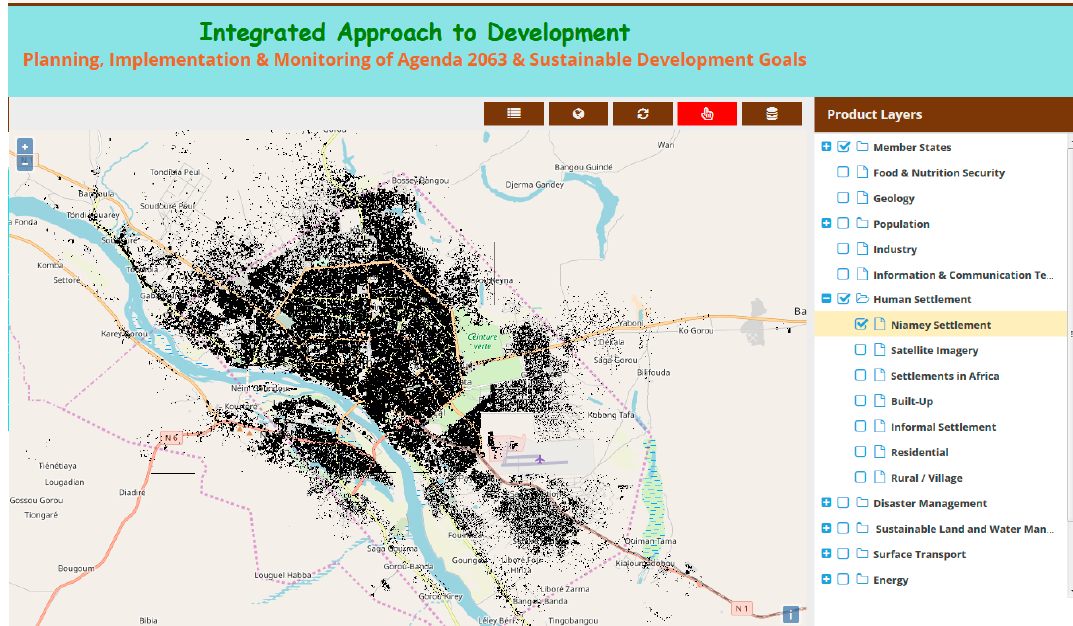
Figure 17. Map overlay operations. Human settlements layer over the city of Niger.